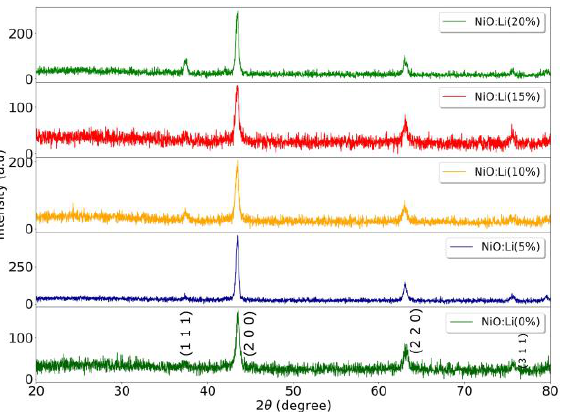
Figure 1. XRD patterns of NiO:Li films deposited with different lithium concentrations in the precursor solution.